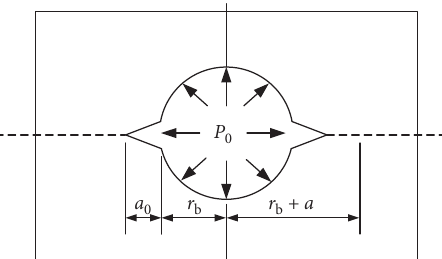
Figure 4: Mechanical model of rock cracking induced by deto- nation